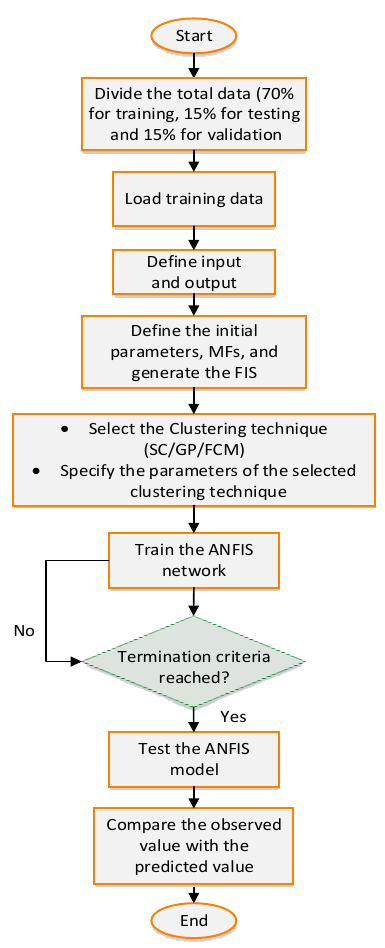
Figure 2. Flowchart of the proposed ANFIS model.